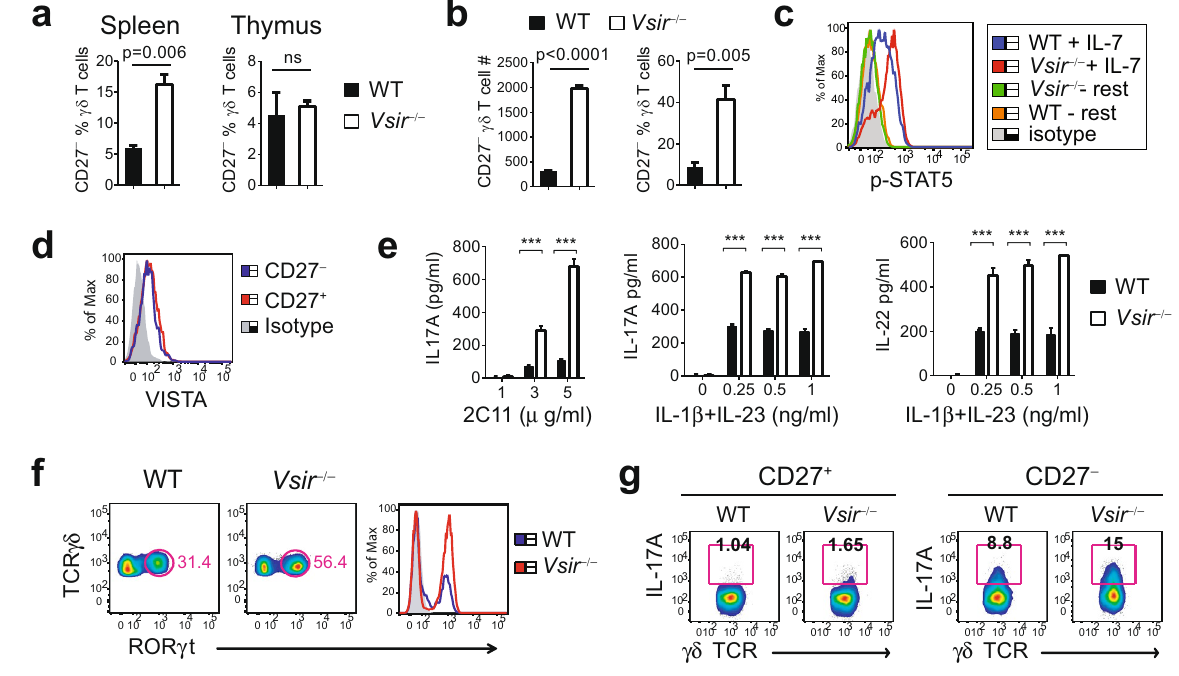
Figure 4. VISTA controls the peripheral homeostasis and activation of γδ T cells. ( a ) Naive γδ T cells were isolated from WT or Vsir − / − mice and their surface expression of CD27 was examined by flow cytometry (n = 4). The percentage of the CD27 − subset is shown (mean ± SEM). ( b and c ) Naïve γδ T cells from WT and Vsir − / − mice (n = 4) were stimulated in vitro with IL-7 (10 ng/ml). The number and percentage of viable CD27 − γδ T cells were quantified by flow cytometry after 4 days. Phosphorylated STAT5 was examined by intracellular staining and flow cytometry. ( d ) VISTA expression on CD27 + and CD27 − naïve splenic γδ T cells was examined by flow cytometry. ( e – g ) Naïve splenic γδ T cells were purified from WT and Vsir − / − mice (cells pooled from 4 mice of each strain), and stimulated with either immobilized anti-CD3 ε mAb (2C11) or cytokines IL-1 β and IL-23. Culture supernatants were harvested after 24 hrs and the levels of IL-17A and IL-22 were examined by ELISA. Values from triplicated cultures are shown as mean ± SEM ( e ). Expression of ROR γ t at 24 hrs following IL-1 β (0.25 ng/ml) and IL-23 (0.25 ng/ml) stimulation was examined by intracellular staining and flow cytometry ( f ). The percentage of IL-17A-producing CD27 + and CD27 − γδ T subsets was examined by flow cytometry ( g ). *** P < 0.001. Representative results from three independent experiments are